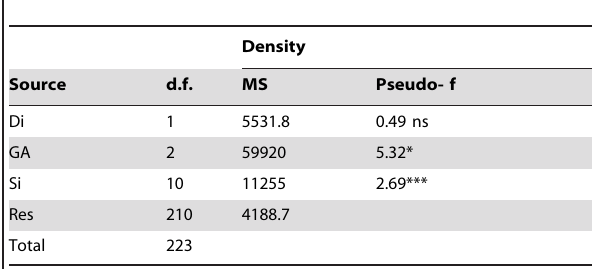
Table 4. PERMANOVA on density data of